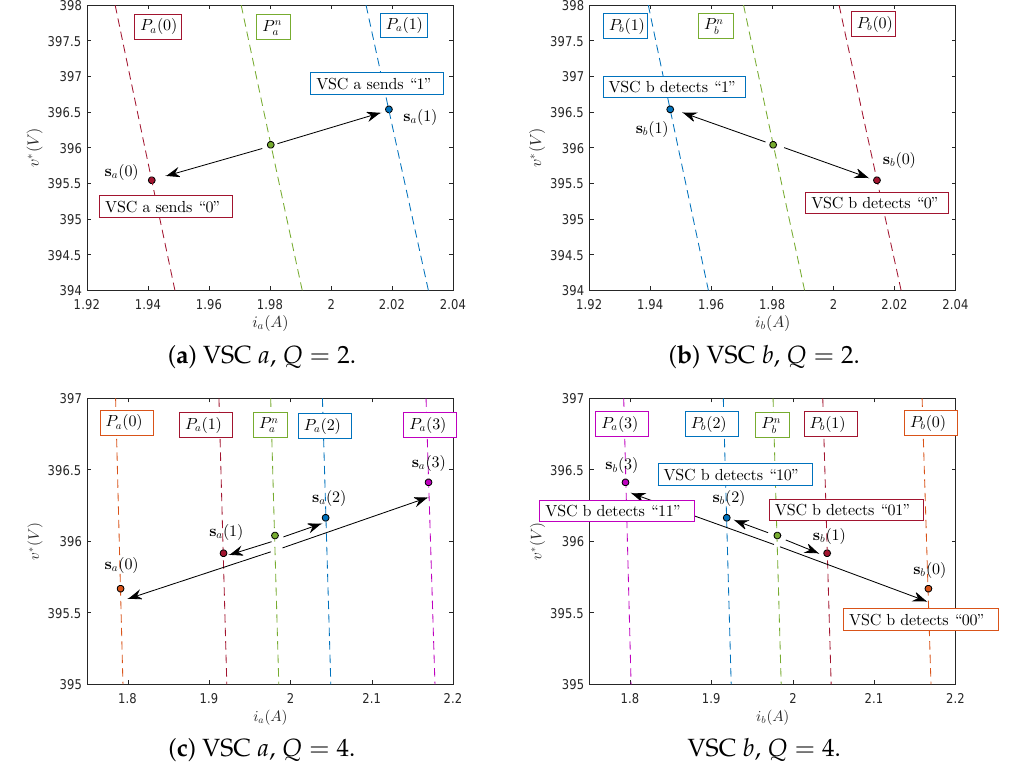
Figure 7. v − i diagram for TDMA-based binary power talk: two VSC units ( a , b ) v 0 = 399 V , v 1 = 401 V , ( c , d ) v 0 = 399.25 V , v 1 = 399.75 V , v 2 = 400.25 V , v 3 = 400.47 V (obtained with PLECS R